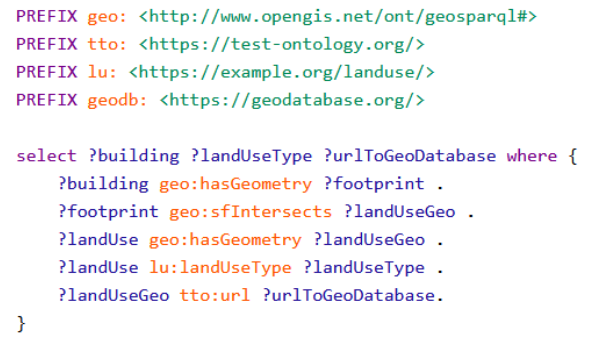
Figure 6. SPARQL query for the question: ‘Which forms of land use are affected by constructing the building? Give the geometry of these land uses.’